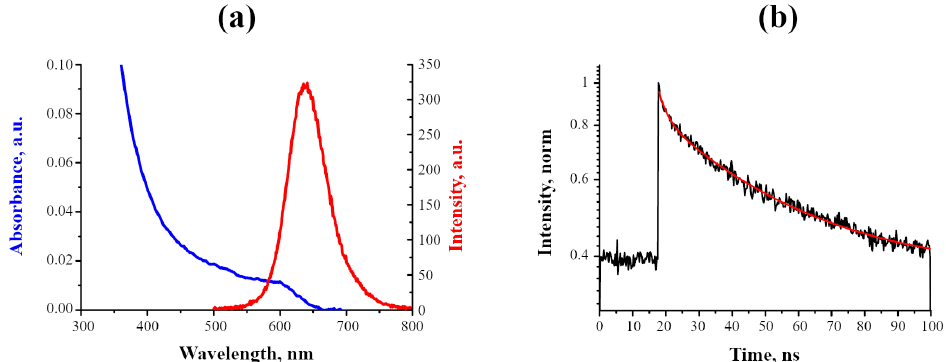
Figure 1. Photophysical properties of InP-QDs (80 nM) in H 2 O. ( a ): Absorption and luminescence spectra; ( b ): Decay curve and its approximation (red